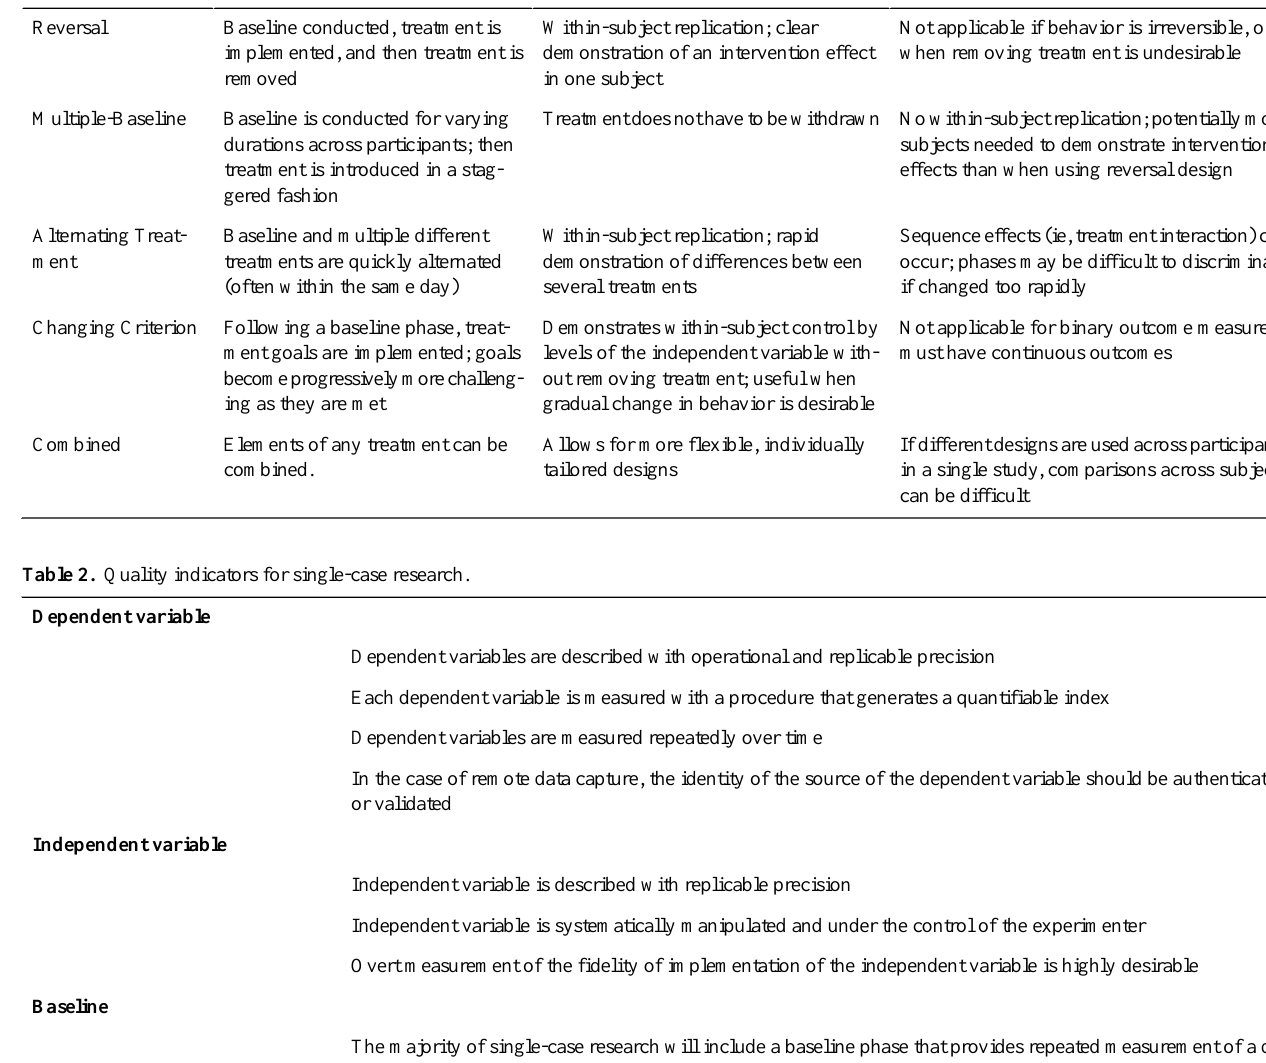
Table 1. Common single-case designs, including general procedures, advantages, and disadvantages. DisadvantagesAdvantagesProcedureDesign